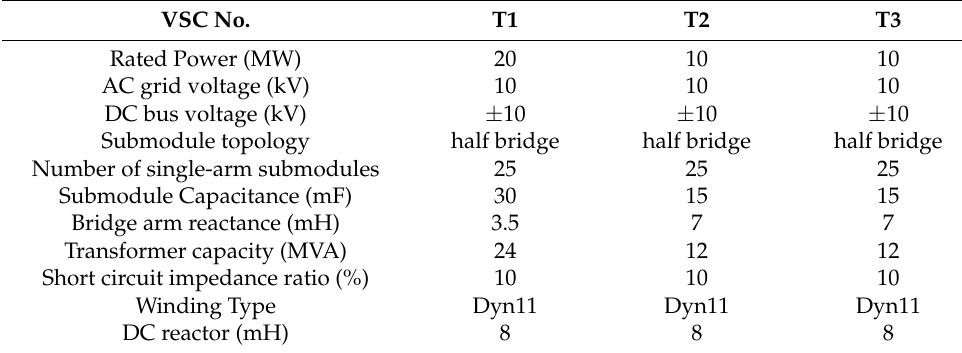
Figure 4. Three-port circuit breaker model. Table 1. Parameters of the three-terminal VSC converter.